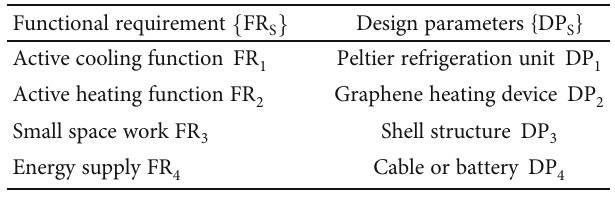
Table 2: Comparison table of functional requirements and design parameters.